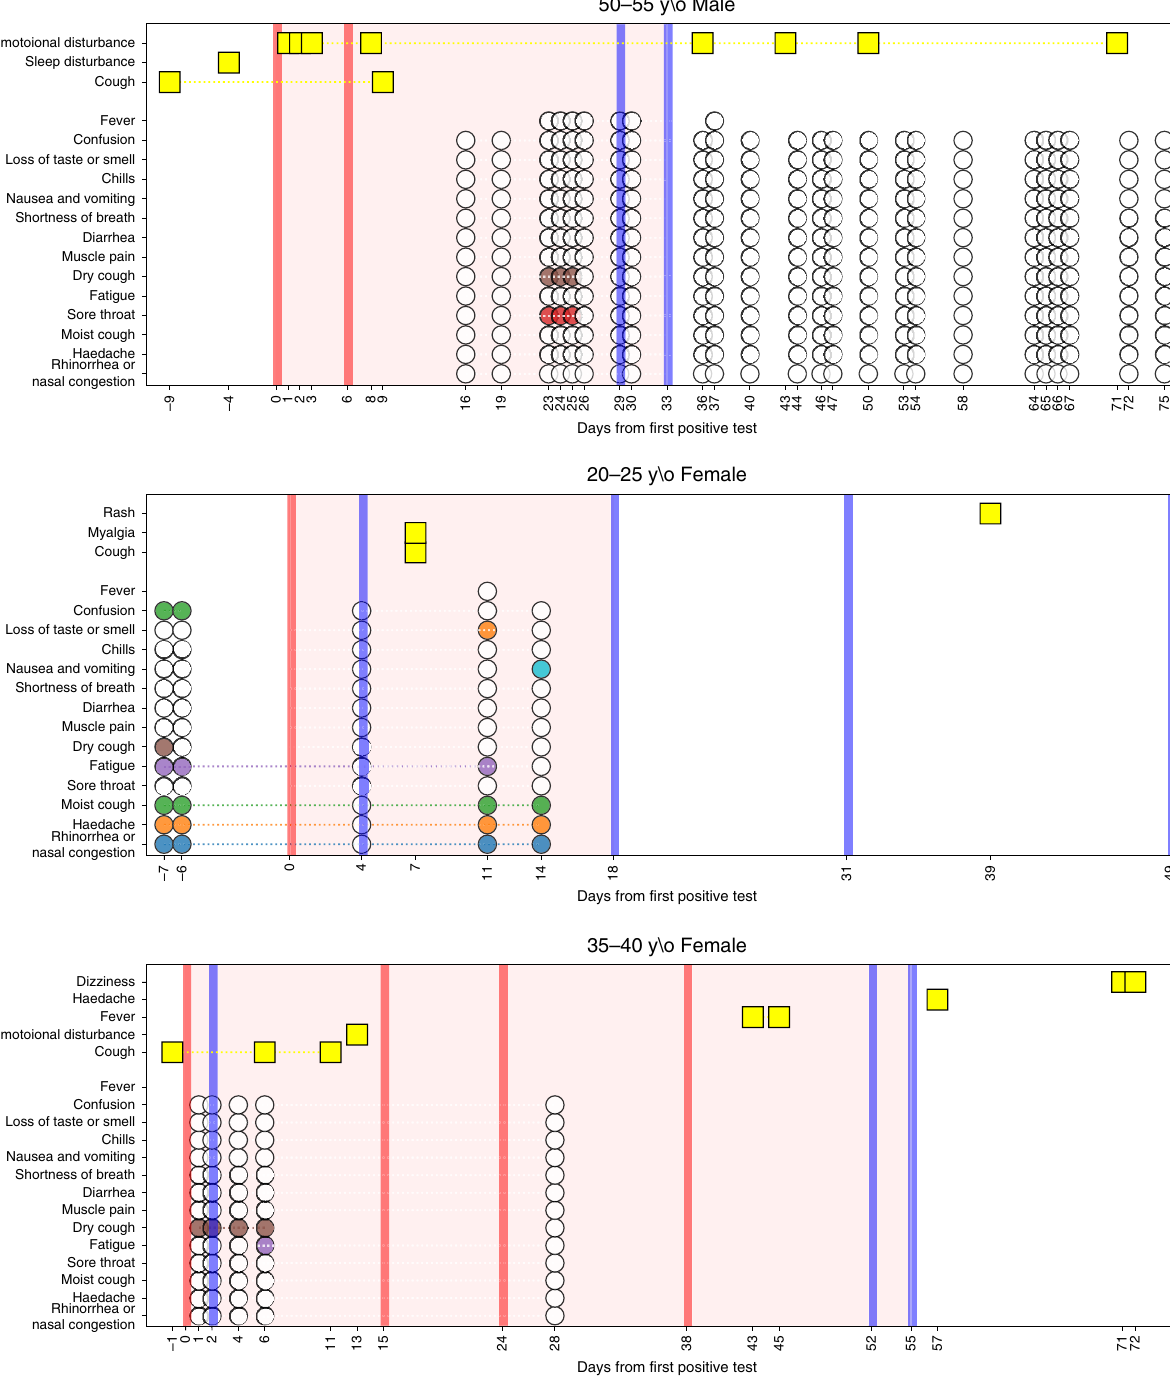
Fig. 1 Longitudinal dynamics of symptoms in infected individuals. Three examples are given. Yellow rectangles represent symptoms recorded by a physician at a primary care visit. Colored circles represent symptoms self-reported by the individual throughout the survey. White circles represent self- report of not experiencing a symptom through the survey. Red and blue vertical lines indicate a positive or negative PCR test for SARS-CoV-2, respectively. The area marked in light red indicates the period of time an individual was considered as infected with